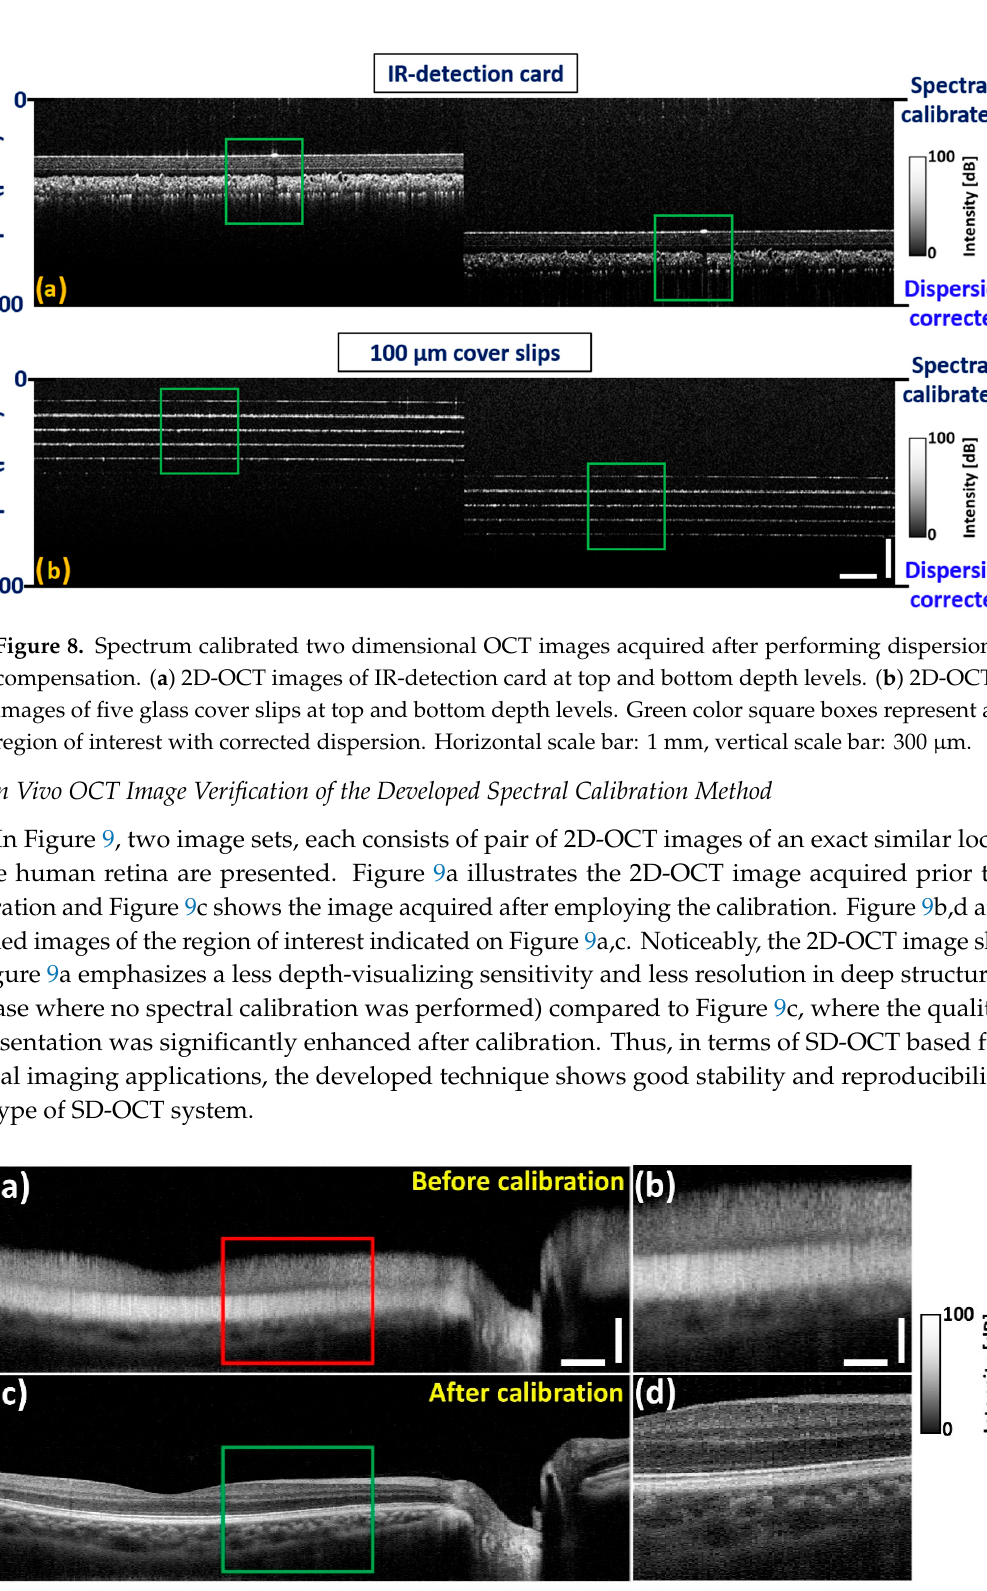
Figure 9. Image comparison with and without spectral calibrated in vivo human retina. ( a ) In vivo human retinal image before (without) spectral calibration; ( b ) shows magnified view of red box. ( c ) In vivo human retinal image after (with) spectral calibration; ( d ) shows magnified view of green box. ( a ) Horizontal scale bar: 1 mm, vertical scale bar: 300 µ m, ( b ) horizontal scale bar: 500 µ m, vertical scale bar: 150 µ